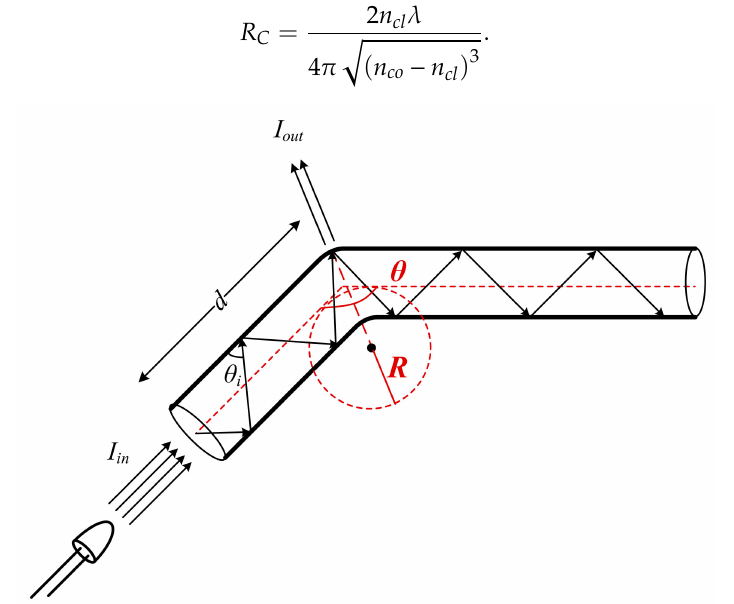
Figure 3. A macrobending of an optical fiber, with the illustration of the input source intensity I in , intensity of the light, which leaves the fiber through the bending I out , the propagation parameters: incidence angle θ i , and length variable d , and the bending parameters: bending radius R and bending angle θ